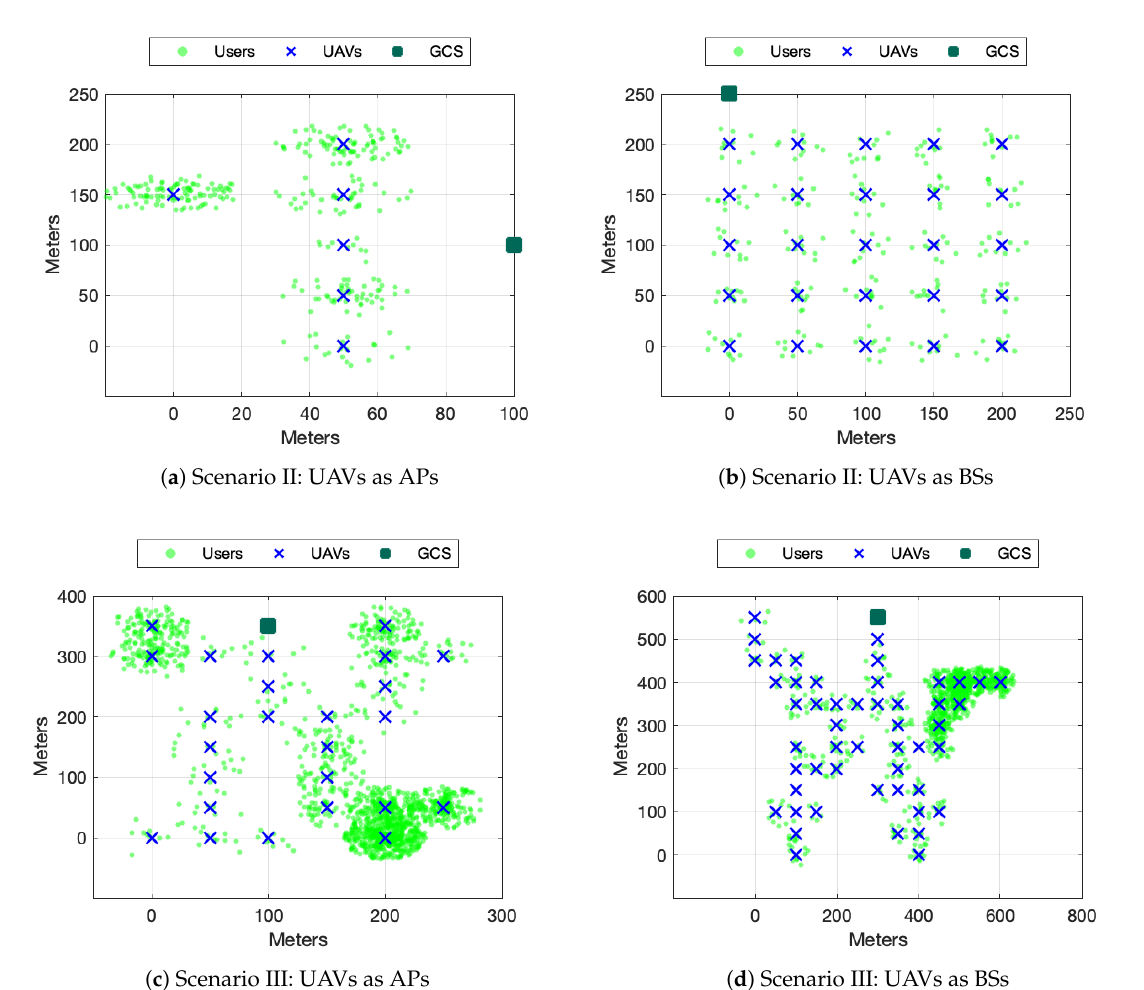
Figure 5. Proposed scenarios for algorithm performance